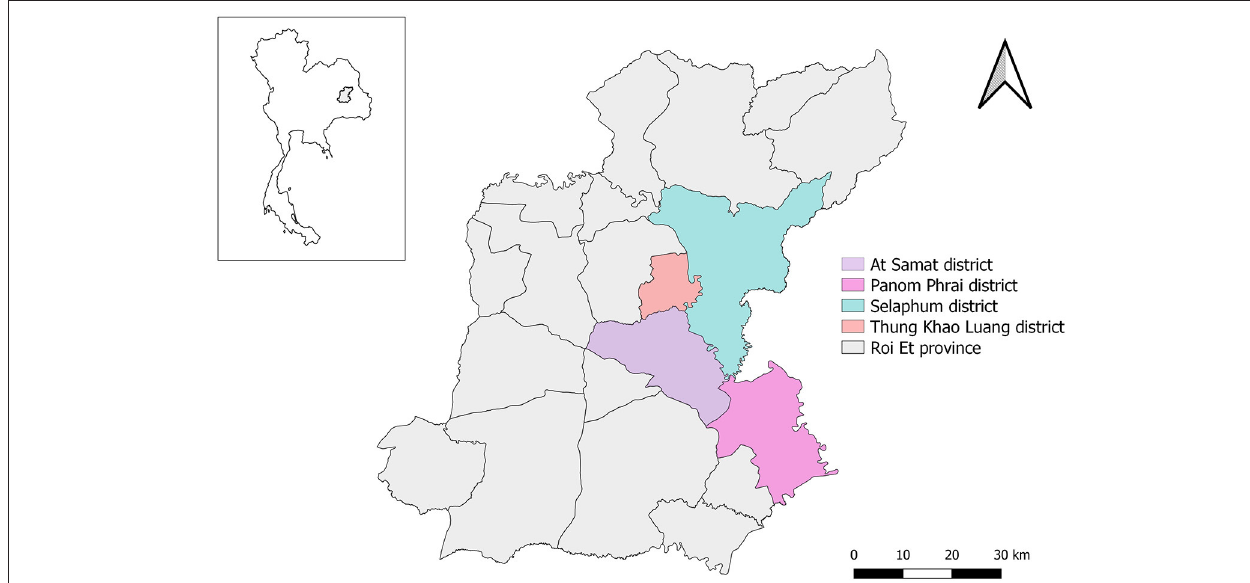
FIGURE 1 | Study areas of LSD outbreak in four districts in Roi Et province, Thailand.